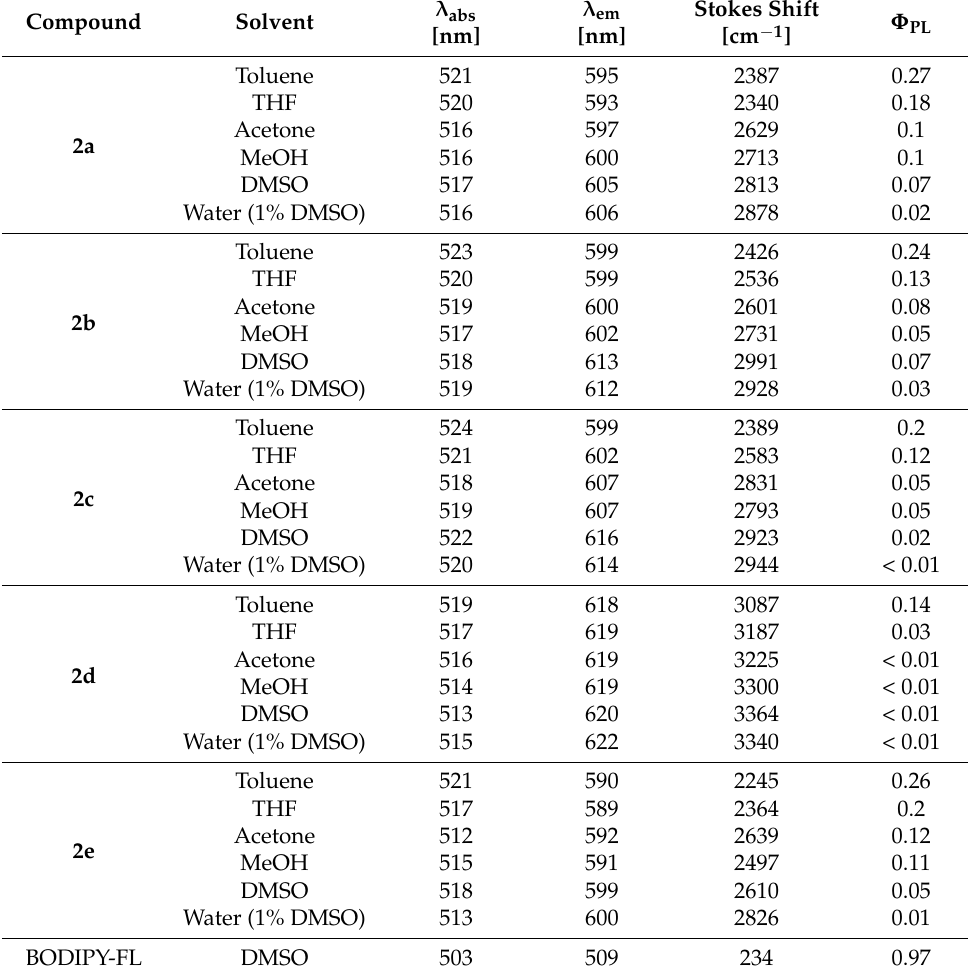
Table 1. Photophysical properties of BODIPY compounds ( 2a – 2e ) and the standard BODIPY